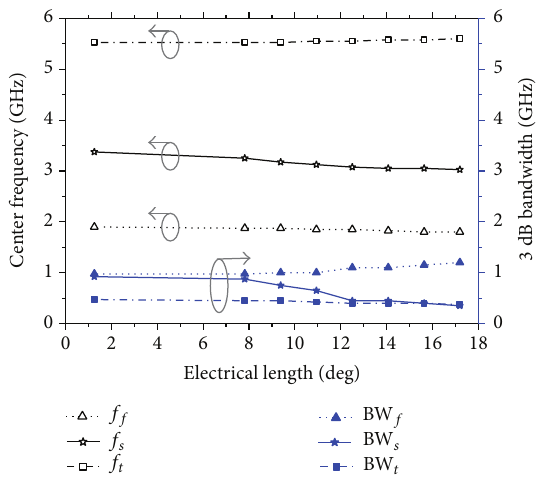
Figure 7: Plot of the variation of the center frequencies and bandwidths of the TBBSF versus the varied electrical length ( 𝜃 3𝑏 ) for the proposed TSSIR 𝑏 shows that 𝑓 𝑠 and BW 𝑓 can be controlled at almost constant 𝑓 𝑓 , 𝑓 𝑡 and BW 𝑓 , BW 𝑡 , respectively.